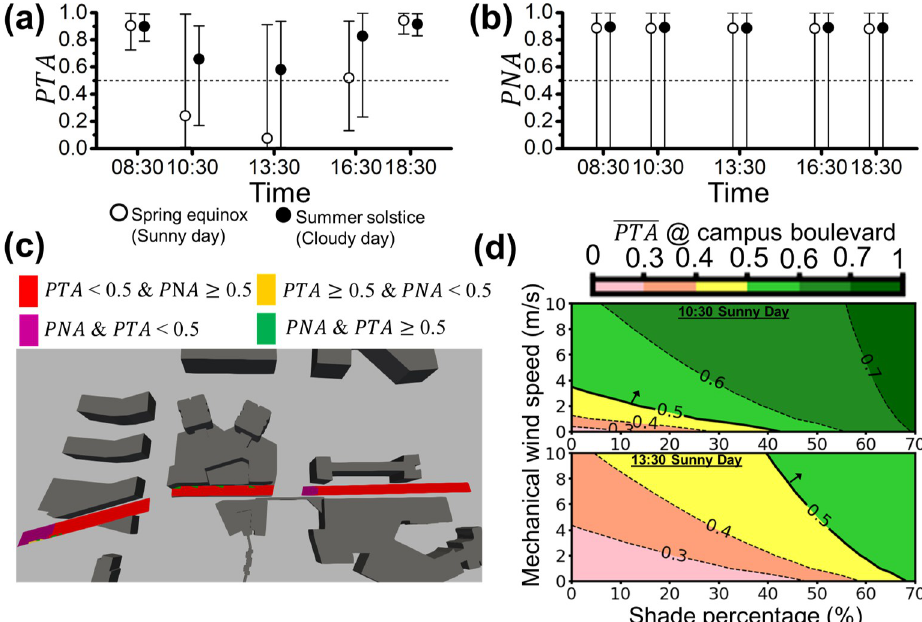
Fig 9. The area-averaged (a) PTA and (b) PNA of the campus boulevard (site (i)) for both sunny (open circles) and cloudy (filled circles) days are represented with open and filled circles (i.e., PTA and PNA ), respectively. The error bars extended from the area-averaged PTA or PNA (circles) represent the local maximum and local minimum PTA or PNA on the campus boulevard. The environmental acceptability threshold of 0.5 is denoted by the dotted line (i.e., PTA = 0.5 or PNA = 0.5). (c) The spatial plot of PTA and PNA above or below the threshold of 0.5 for campus boulevard at 13:30 on the sunny day (worst case) is illustrated. (d) The contour plot shows the potential improvement of PTA with the increase in shade and/or wind speed at 10:30 and 13:30 on the sunny day for the campus boulevard.